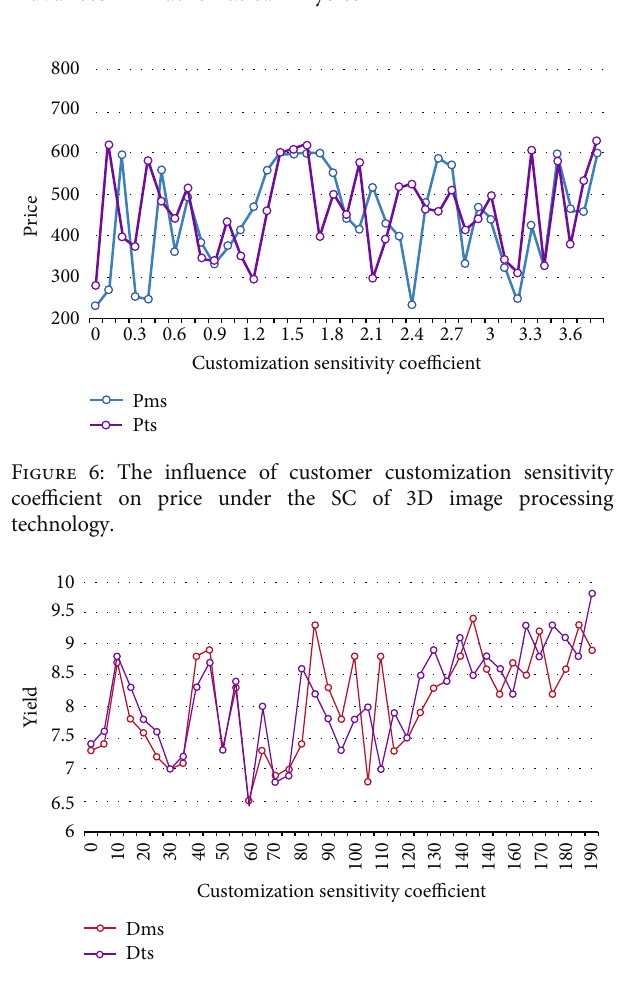
Figure 7: In fl uence of customer customization sensitivity coe ffi cient on output under the SC of 3D image processing technology.